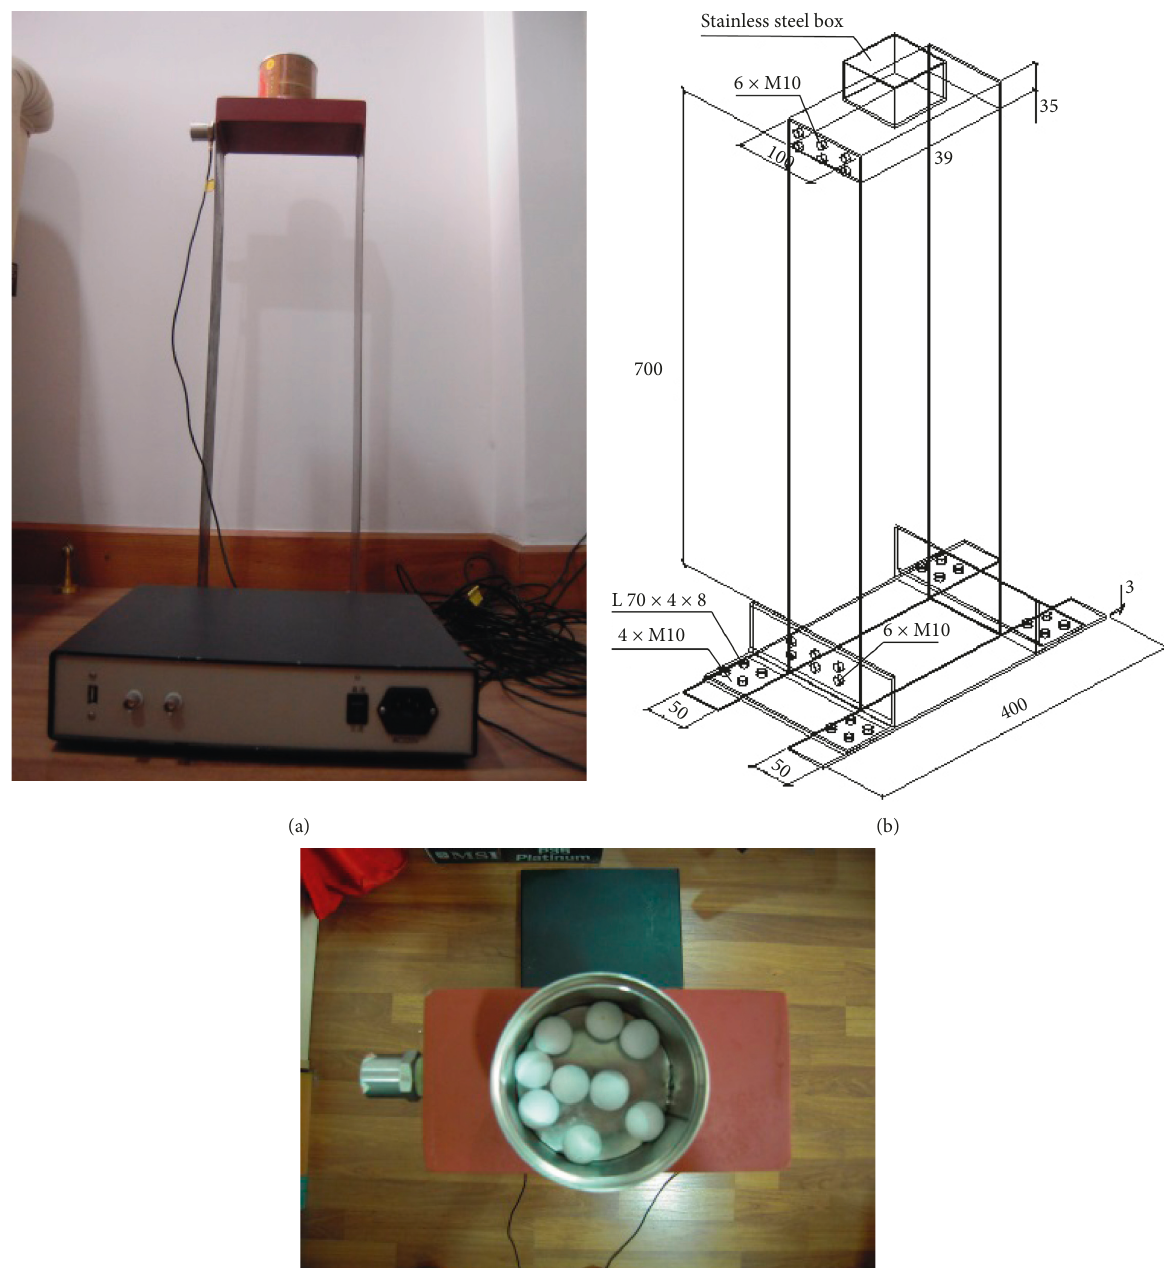
Figure 15: Experimental model of the SDOF frame structure (Unit: mm). (a) Photo. (b) Size. (c) Particle